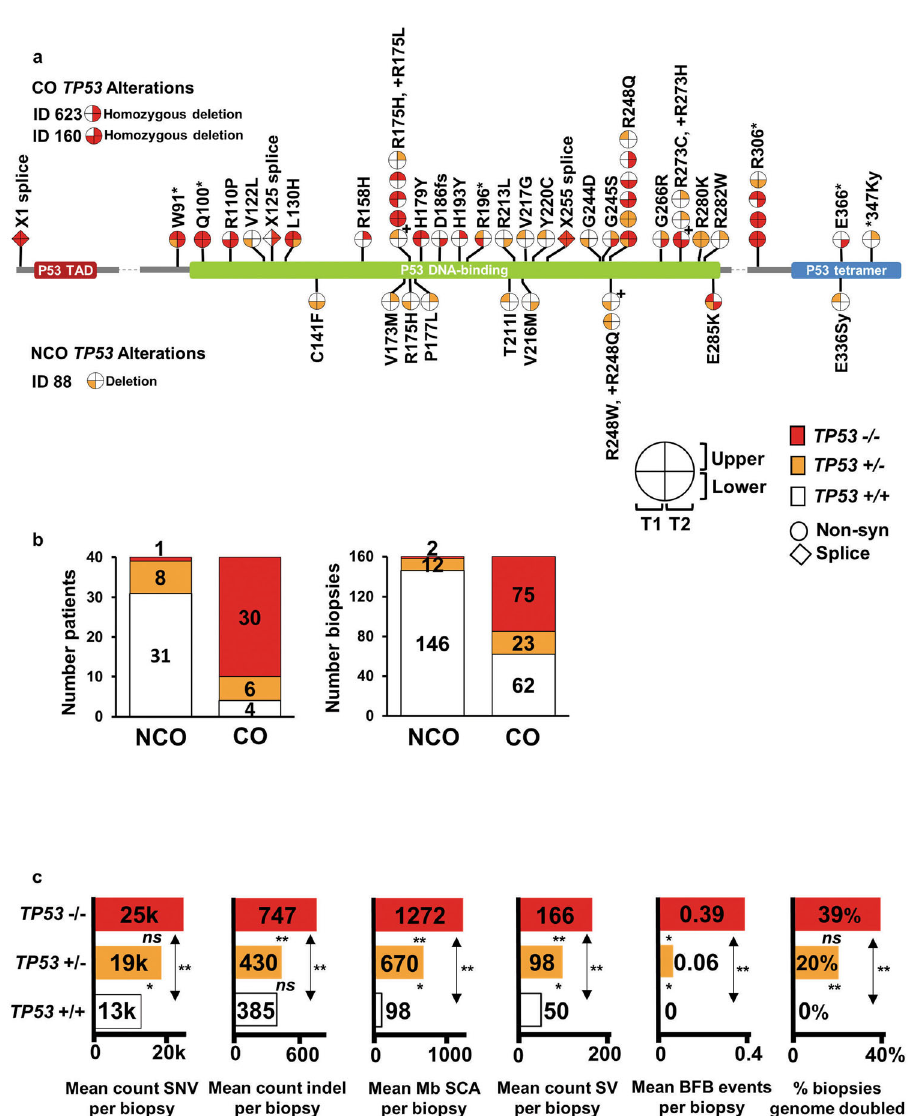
Fig. 5 Expansion of TP53 − / − is a primary characteristic for progression to ESAD. a TP53 mutations in four biopsies per patient collected over time (T1 and T2) and space (upper and lower esophagus) in CO and NCO. Each “ lollipop ” pie on the TP53 gene structure indicates a speci fi c TP53 mutation with quadrants of the lollipop indicating the number of mutant copies in each of the patient ’ s four biopsies. The TP53 biopsy quadrants for two CO with homozygous deletions of TP53 (IDs 623 and 160) and one NCO (ID 88) with single copy deletion (ID 88) spanning TP53 are also plotted for completeness. ( + ) next to a pie corresponds to the amino acid change marked by ( + ). b , Proportions of patients and biopsies with wild-type TP53 + / + (white), one-hit TP53 + / − (orange), and two-hit TP53 − / − (red) status. Of the six one-hit CO, fi ve of the mutations were private and one was shared, and of the eight one-hit NCO, six were private and two shared. c , Somatic alterations strati fi ed by TP53 zero-hit (n = 208 biopsies), one-hit ( n = 35 biopsies), and two-hit (n = 77 biopsies). Two-sided Mann – Whitney U test was used for each comparison with correction for multiple comparisons. P-values between bars test for signi fi cant difference between TP53 categories, ns = P ≥ 0.05, * = P < 0.05, ** = P < 0.0001. SCA = somatic chromosomal alterations (gains, losses, cnLOH); SV = structural variants; BFB = bridge-fusion-break events. P-values and source data are indicated in Figure Source Data